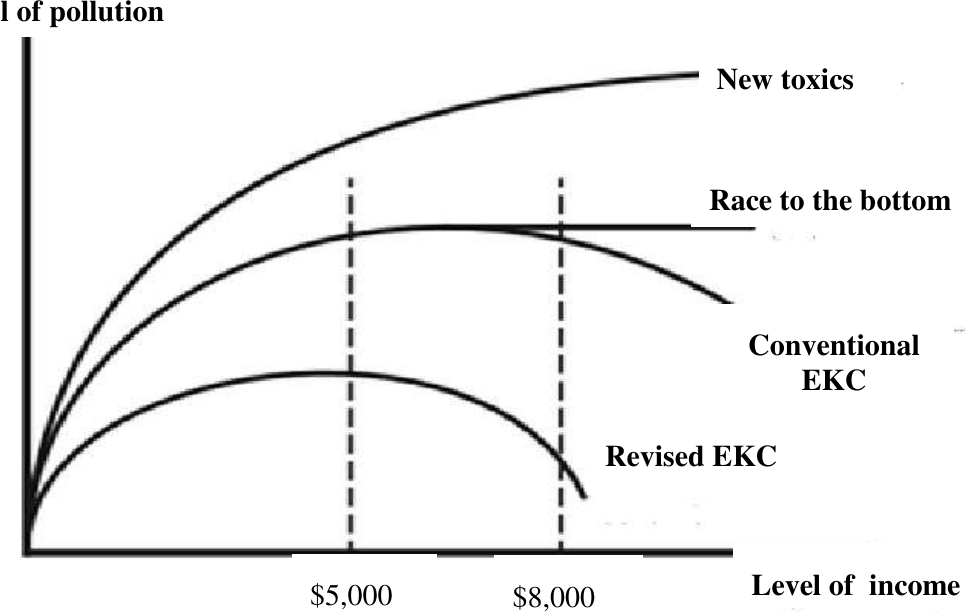
Fig. 2. Different scenarios of environmental Kuznets curve Source: Taguchi